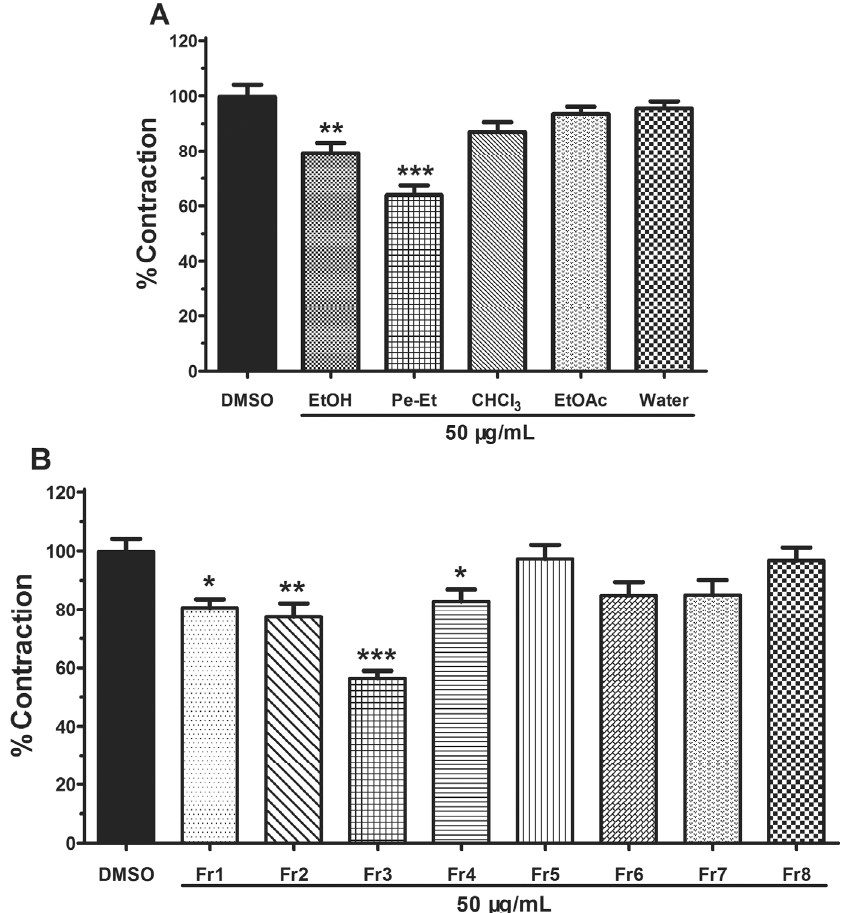
Figure 2. Vasorelaxant effect of all parts from C. opobalsamum on the PE-induced constriction of rat pulmonary artery. ( A ) Vascular effect of EtOH extract (EtOH) and four partitions [petroleum ether-soluble (Pe-Et), chloroform-soluble (CHCl (EtOAc) and water-soluble (Water)] obtained from that extract. ( B ) Eight fractions of petroleum ether-soluble. Results are presented as means ± SEM, n = 5. * p < 0.05, ** p < 0.01 and *** p < 0.001 compared to vehicle